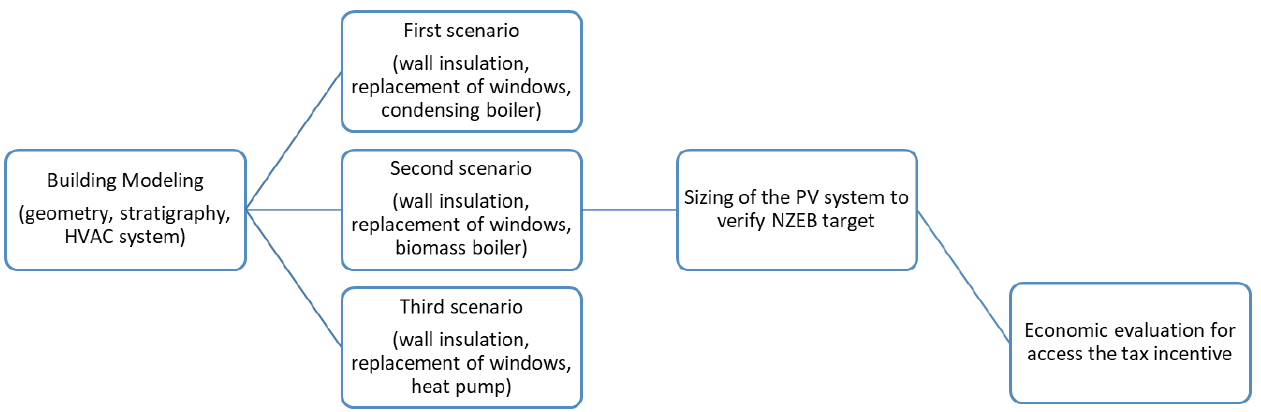
Figure 4. Workflow of the methodology applied to a case study.